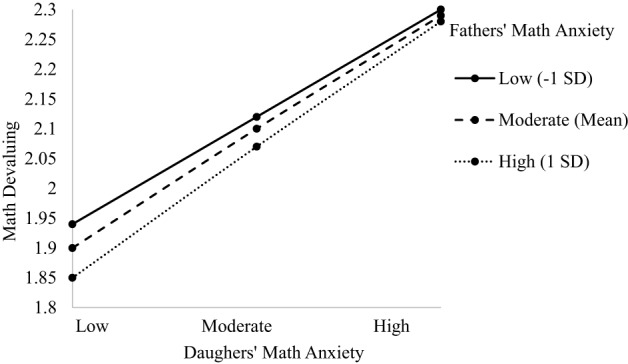
Three-way interaction predicting math devaluing from Fathers' and Daughters' math anxiety.